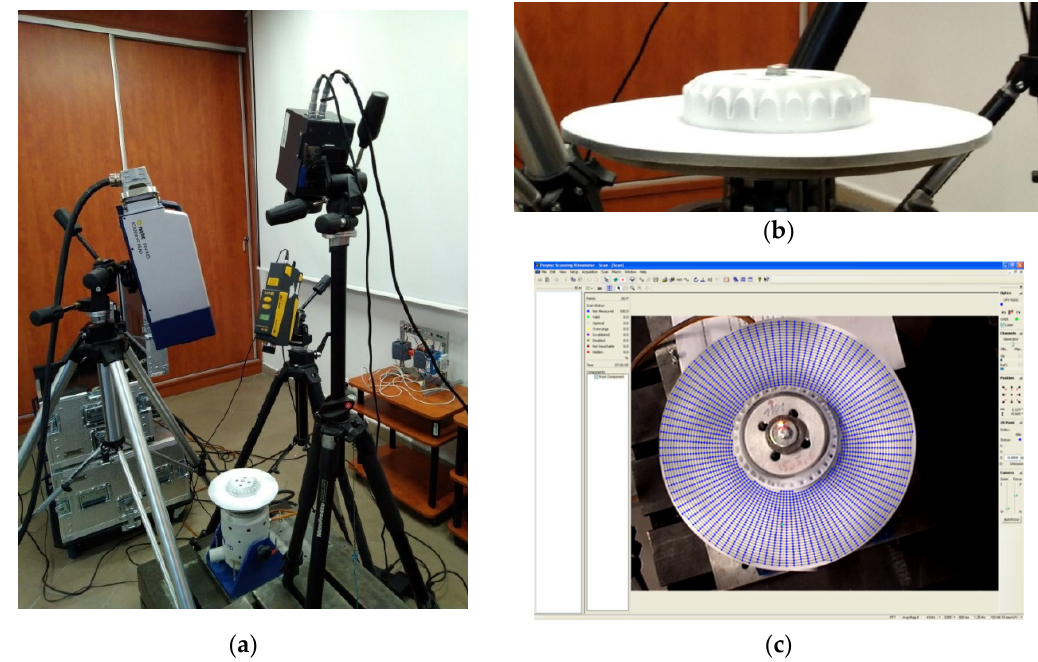
Figure 4. The experimental setup for vibration testing of PMC disks: ( a ) General view; ( b ) The view of the tested disk covered by the reflective powder; ( c ) The view from the vibrometer’s camera with the defined grid of measurement points.